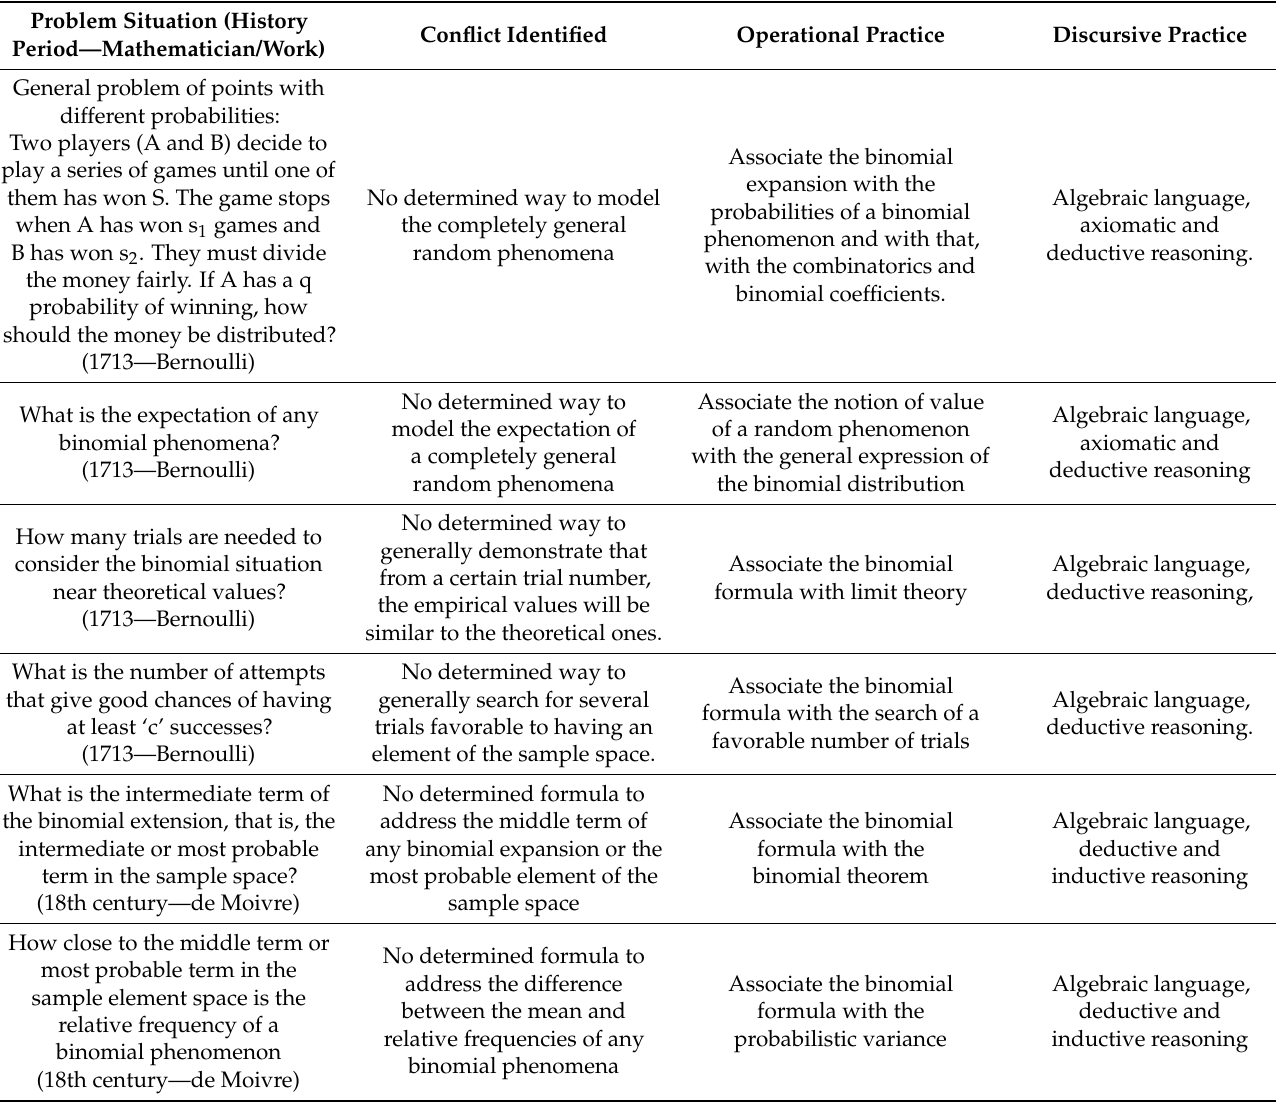
Table 9. Historical problem situations (18th century